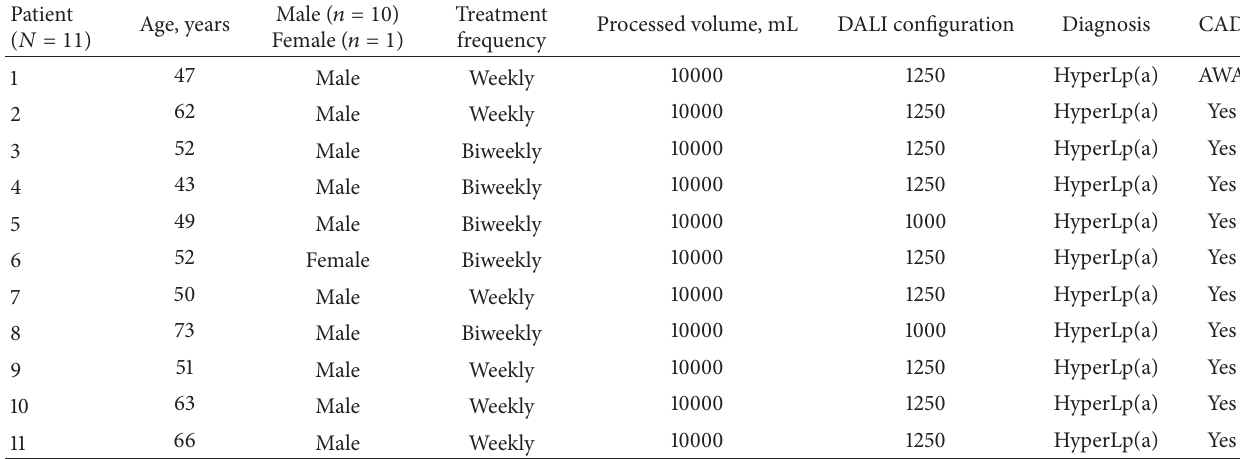
Table 1: Patient demographics and diagnosis and details of lipoprotein apheresis